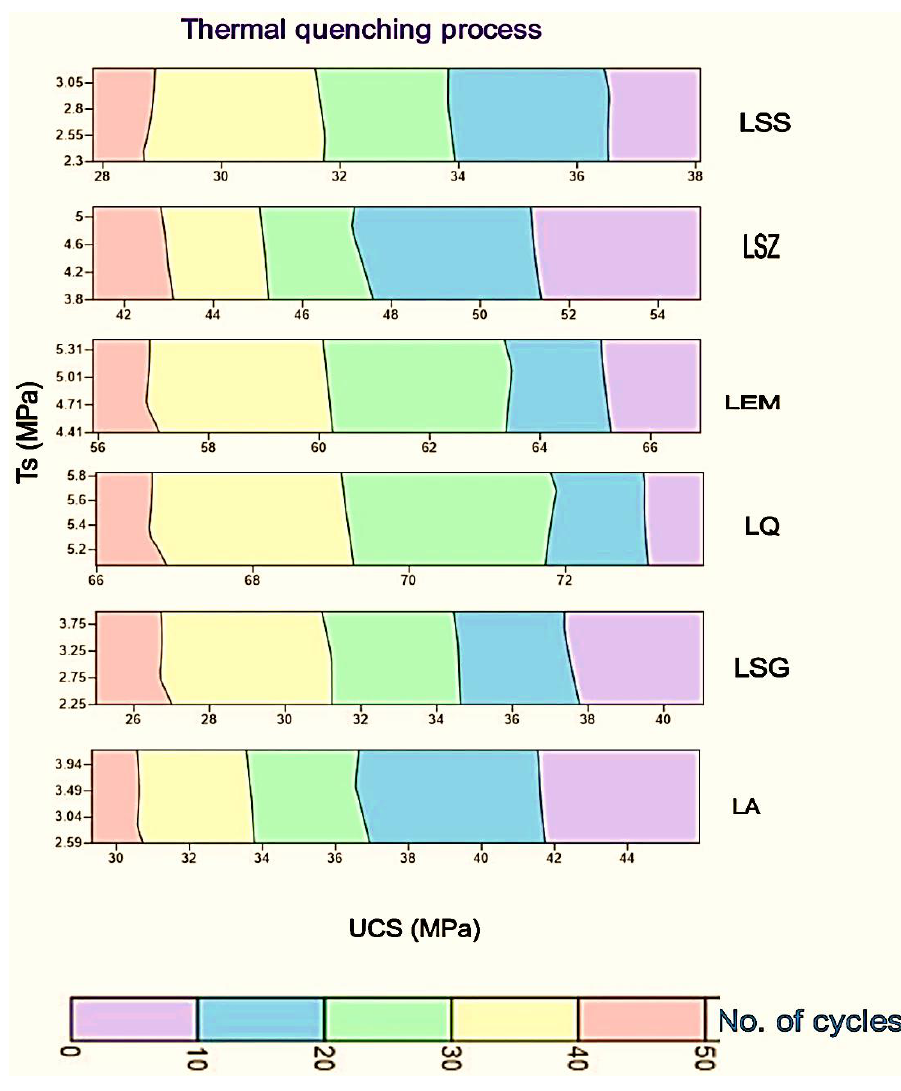
Figure 5. Relationship between TS and UCS values and number of thermal quenching